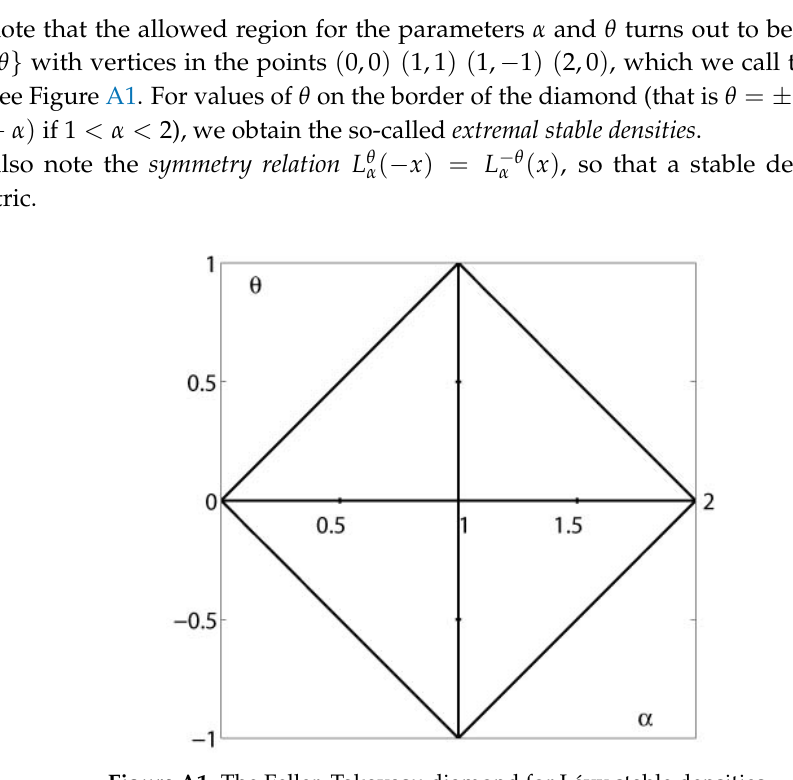
Figure A1. The Feller–Takayasu diamond for Lévy stable